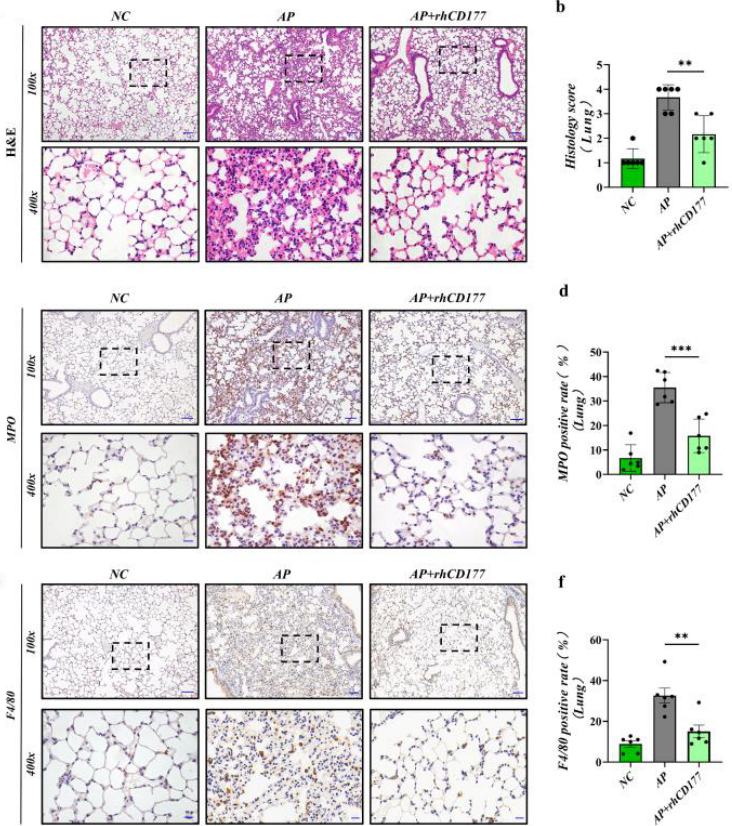
Figure 5. rhCD177 can protect against AP-induced acute lung injury and attenuate inflammatory responses. ( a ) Representative HE stains of lung tissues at magnifications 100× and 400×. Scale bar = 20 μM. ( b ) Pathological scores of lung tissues. ( c ) Representative immunohistochemical images for MPO expression in lung tissues at magnifications 100× and 400× Scale bar = 20 μM. ( d ) Quantifica- tion of MPO-positive cells in each group ( n = 6 per group). ( e ) Representative immunohistochemical images for F4/80 expression in lung tissues at magnifications 100× and 400× . Scale bar = 20 μM. ( f ) Frequencies of F4/80 positive rate in lung tissues ( n = 6 per group). Black dots represent samples. Statistical significance is indicated by ** p < 0.01, *** p < 0.001.